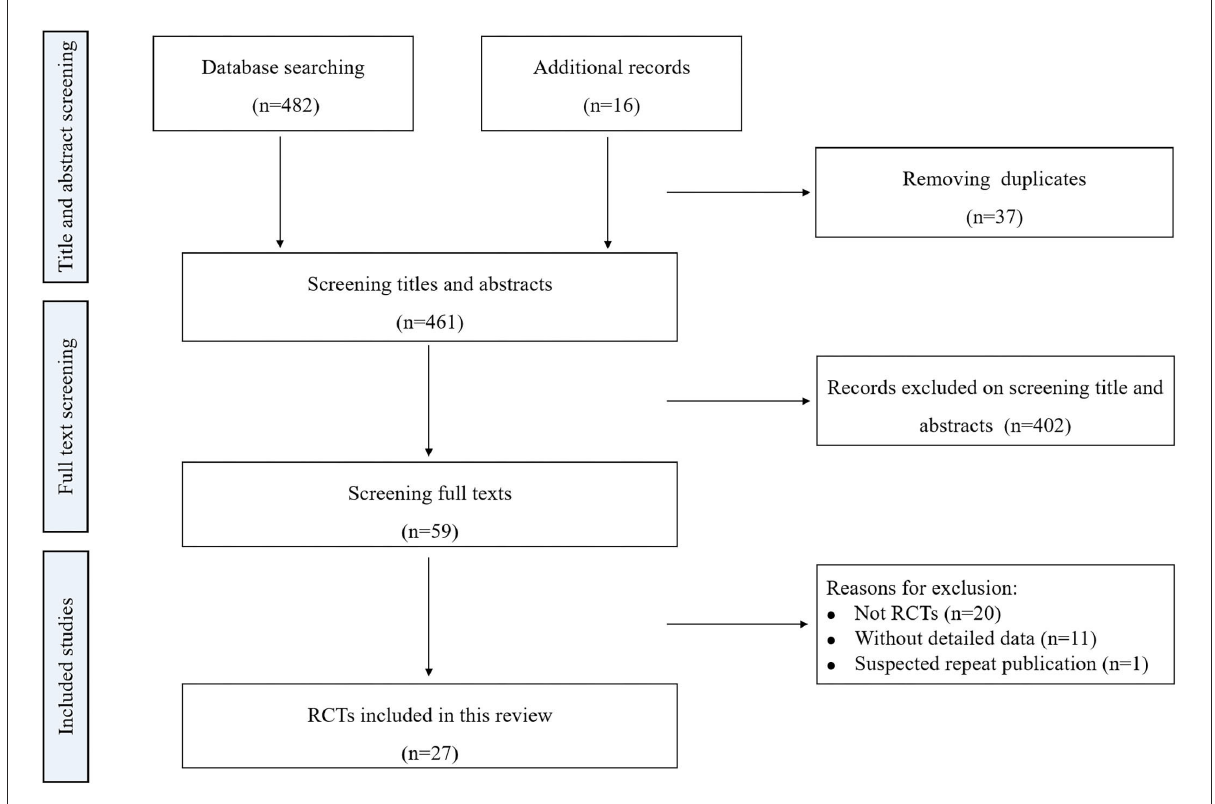
FIGURE1 Flow chart for the meta-analysis. RCTs: randomized controlled